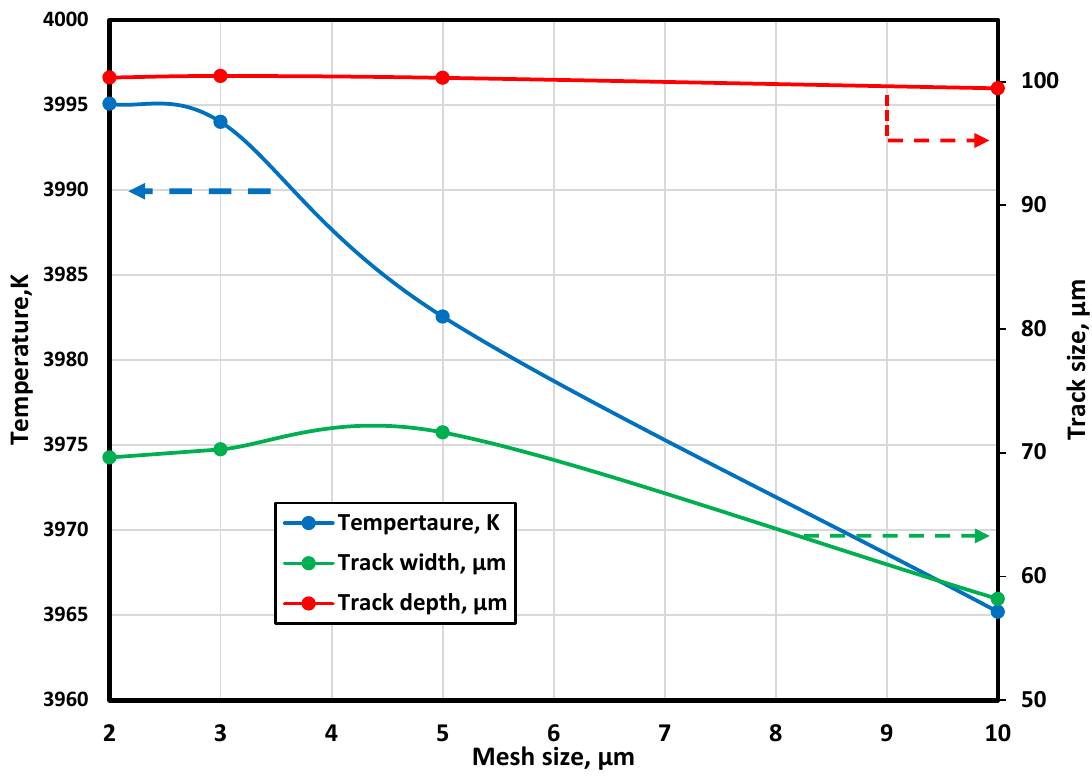
Figure 8 . Mesh density analysis result.